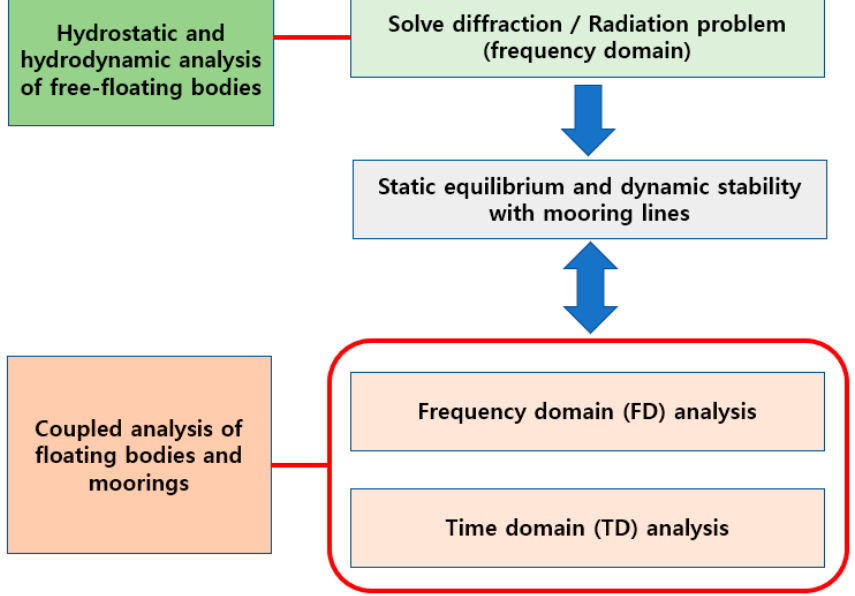
Figure 2. Example of global performance analysis procedure.